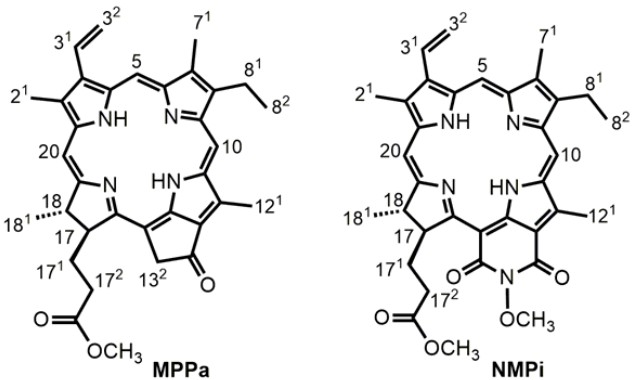
Figure 1. Chemical structures with numbering for methyl pyropheophorbide a (MPPa) and N -methoxyl purpurinimide (NMPi).